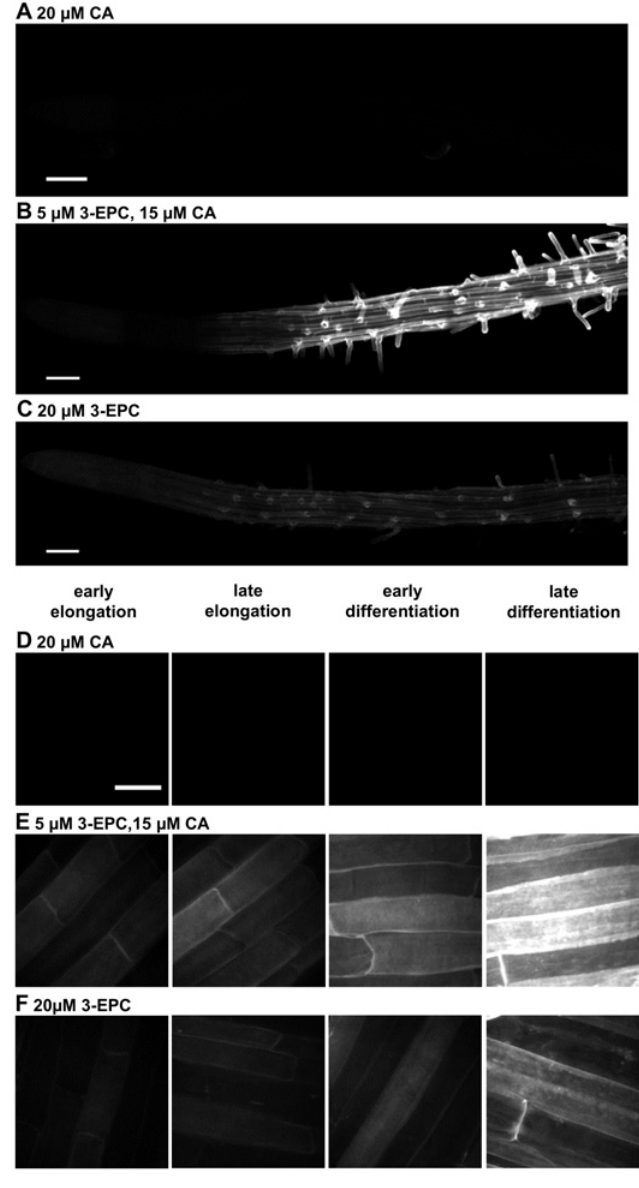
15 μ M CA for 4 h and labeled with Alexa-594 azide for 1 h. (C, F) seedlings treated with 20 μ M 3-EPC for 4 h and labeled with Alexa-594 azide for 1 h. Images were collected with a spinning disk confocal microscope using a 561 nm laser at 10% power and 500 gain with an exposure time of 400 msec. (A-C) contrast- enhanced mosaics of contiguous images, starting at the root tip and going through the late differentiation zone, recorded using a 20X objective (Scale bar, 100 μ m). (D-F) contrast-enhanced maximum intensity projections of z series recorded at the indicated root zones with a 100X oil-immersion objective (Scale bar, 20 μ